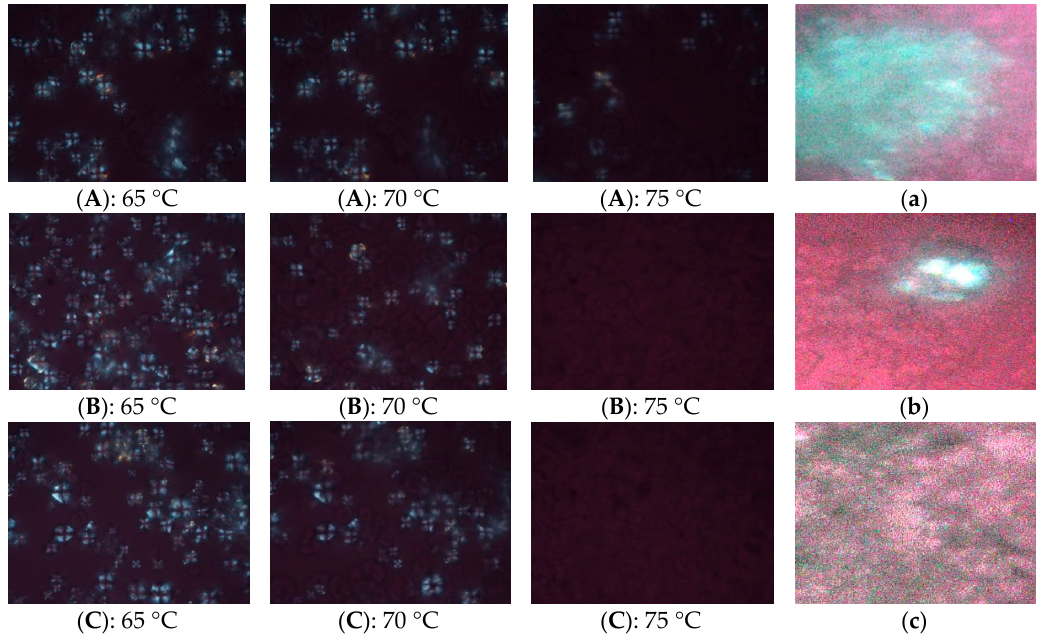
Figure2. Polarizedlightmicrographsofcornflourheatedinthedi ff erenttemperature. ( A , a ):dry-milling corn flour; ( B , b ): wet-milling corn flour; ( C , c ): enzymatic wet-milling corn flour. ( A – C ): polarized light image of corn flour gelatinized at 65 ◦ C, 70 ◦ C, 75 ◦ C (10 × 50 times). ( a – c ): DSC-scanned corn flour at a microscope (10 × 50